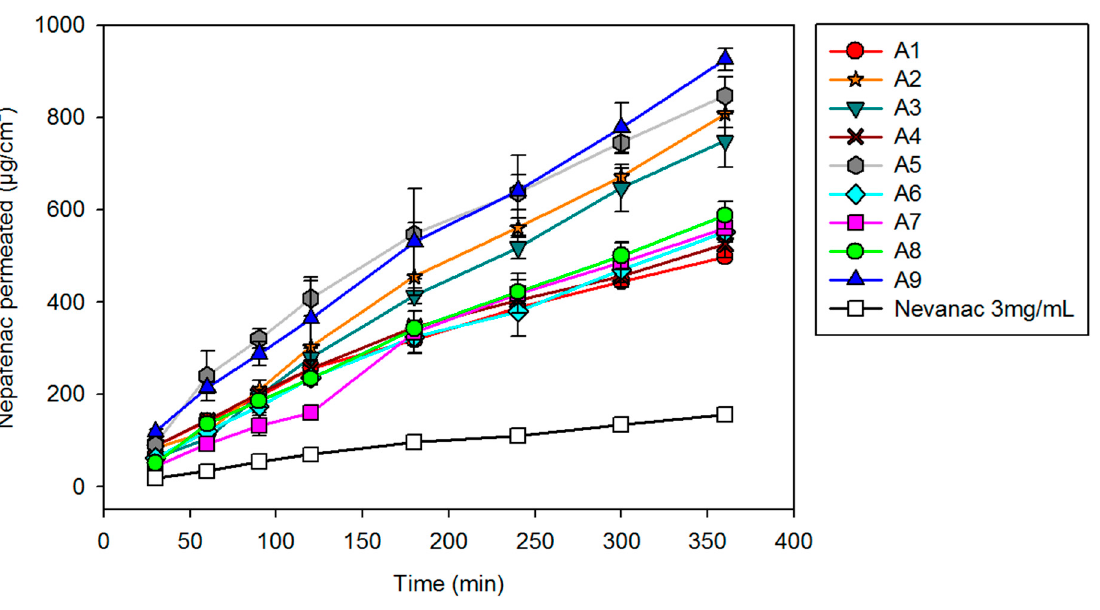
Figure 6. Nepafenac diffusion test through cellulose acetate membrane at 37 °C from eye drop formulations A1 to A9.